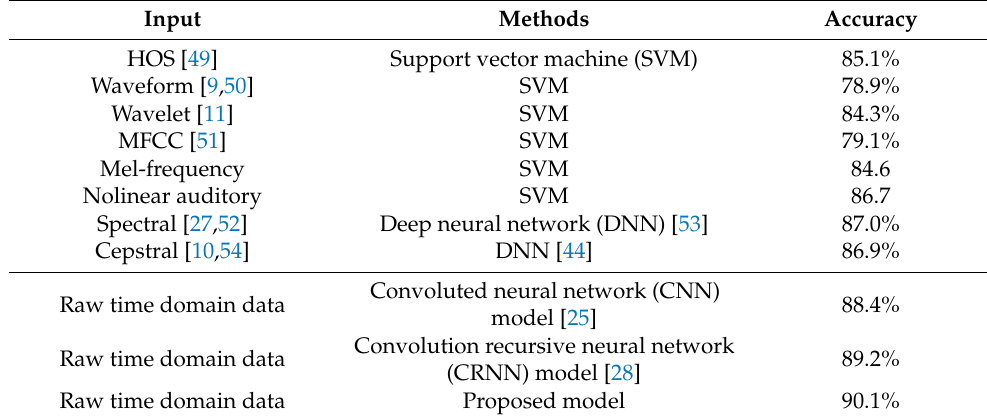
Table 8. The classification results of proposed model and compared models. Input